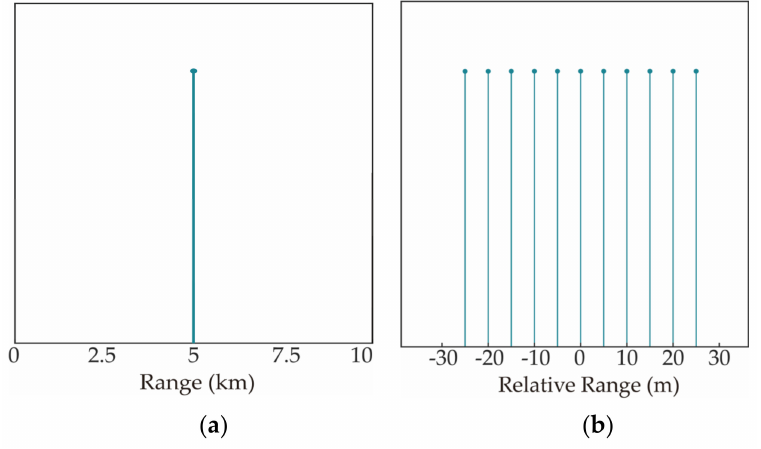
Figure 12. Targets of 11 points with 5 m equal spacing in the range direction. ( a ) The whole scene; ( b ) enlarged target’s area.